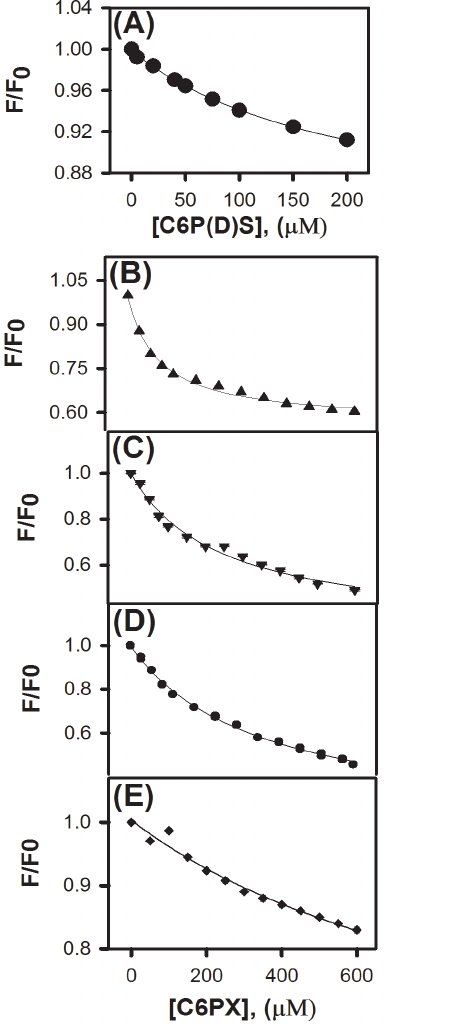
Figure 2. Binding of C6P(D)S, C6PE, C6PA, C6PG & C6PC to FIXa as Detected by Intrinsic Fluorescence. Integrated intrinsic fluorescence of 0.20 m M FIXa in 50 mM Tris, 150 mM NaCl, 5 mM CaCl 2 , and 0.6% PEG, pH 7.5 was measured as a function of C6P(D)S (Frame A), C6PE (Frame B), C6PG(Frame C), C6PA (Frame D) and C6PC (Frame E) concentration at 22 u C to monitor binding. Single-site analysis ( i.e. , hyperbolic fits) of these curves provided apparent K d ’s of 208, 66, 238, 307 and 2000 m M, respectively.